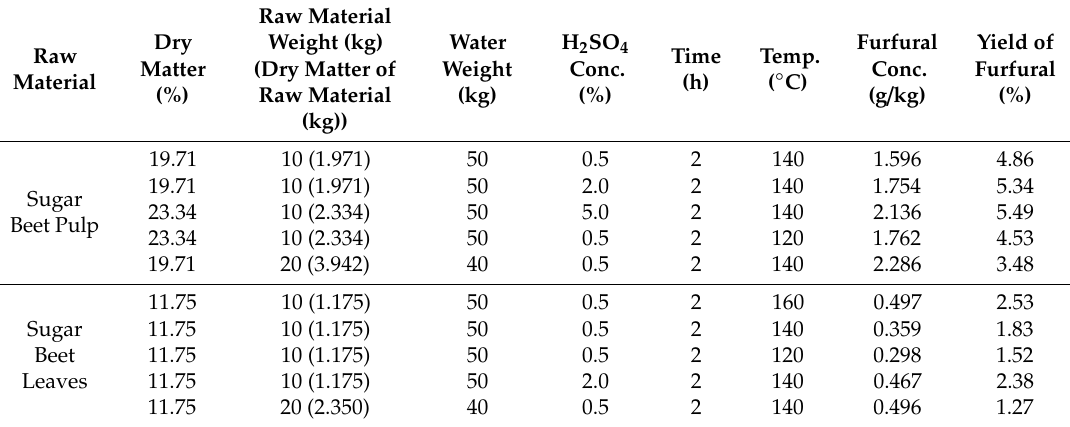
Table 3. Influence of material and processing parameters on the e ffi ciency of furfural production on a quarter-technical scale at the Dobrzelin Sugar